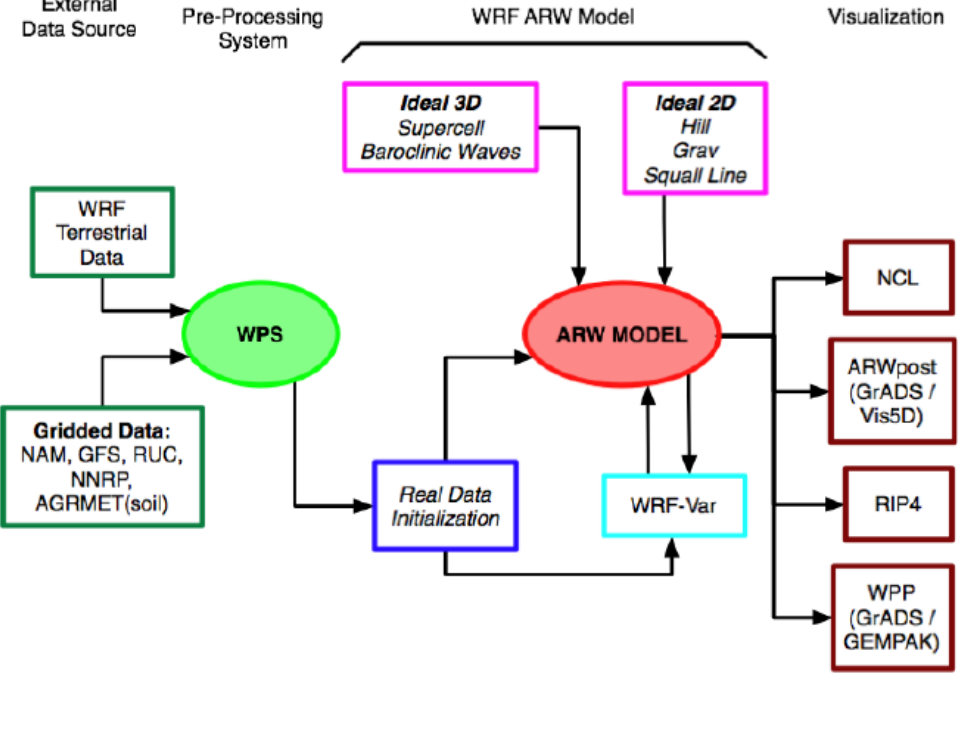
Figure 2. Flowchart for the WRF Modeling System, and the major Program Components consists of (1) The WRF Preprocessing System (WPS), (2) WRF-Var, (3) ARW Model solver, and (4) Post-processing graphics tools. The program units are described in the text, and details are available in the user guide